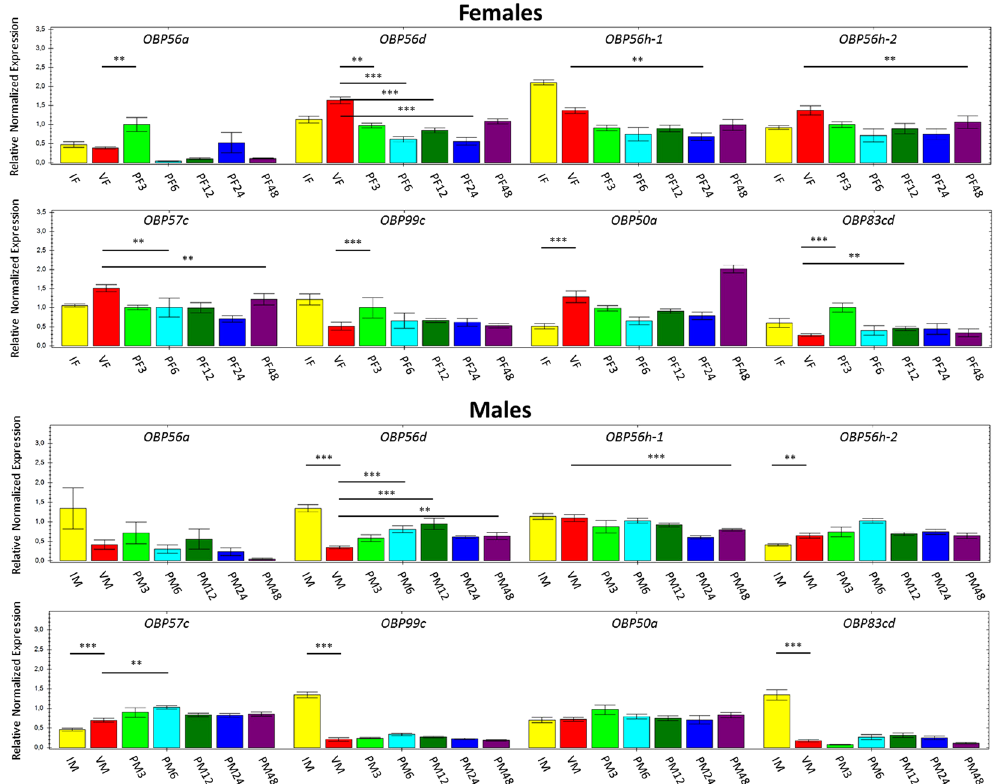
Figure 2. Relative normalized expression of OBP genes in A . fraterculus reproductive stages according to qPCR analyses. IF = immature female; VF = virgin female; PF3 = 3 h post-mating female; PF6 = 6 h post- mating female; PF12 = 12 h post-mating female; PF24 = 24 h post-mating female; PF48 = 48 h post-mating female; IM = immature male; VM = virgin male; PM3 = 3 h post-mating male; PM6 = 6 h post-mating male; PM12 = 12 h post-mating male; PM24 = 24 h post-mating male; PM48 = 48 h post-mating male. Pairs of profiles significantly differentially expressed are show at the endpoints of each line above the bars. Unpaired t-test: ** p-value < 0.01; *** p-value <